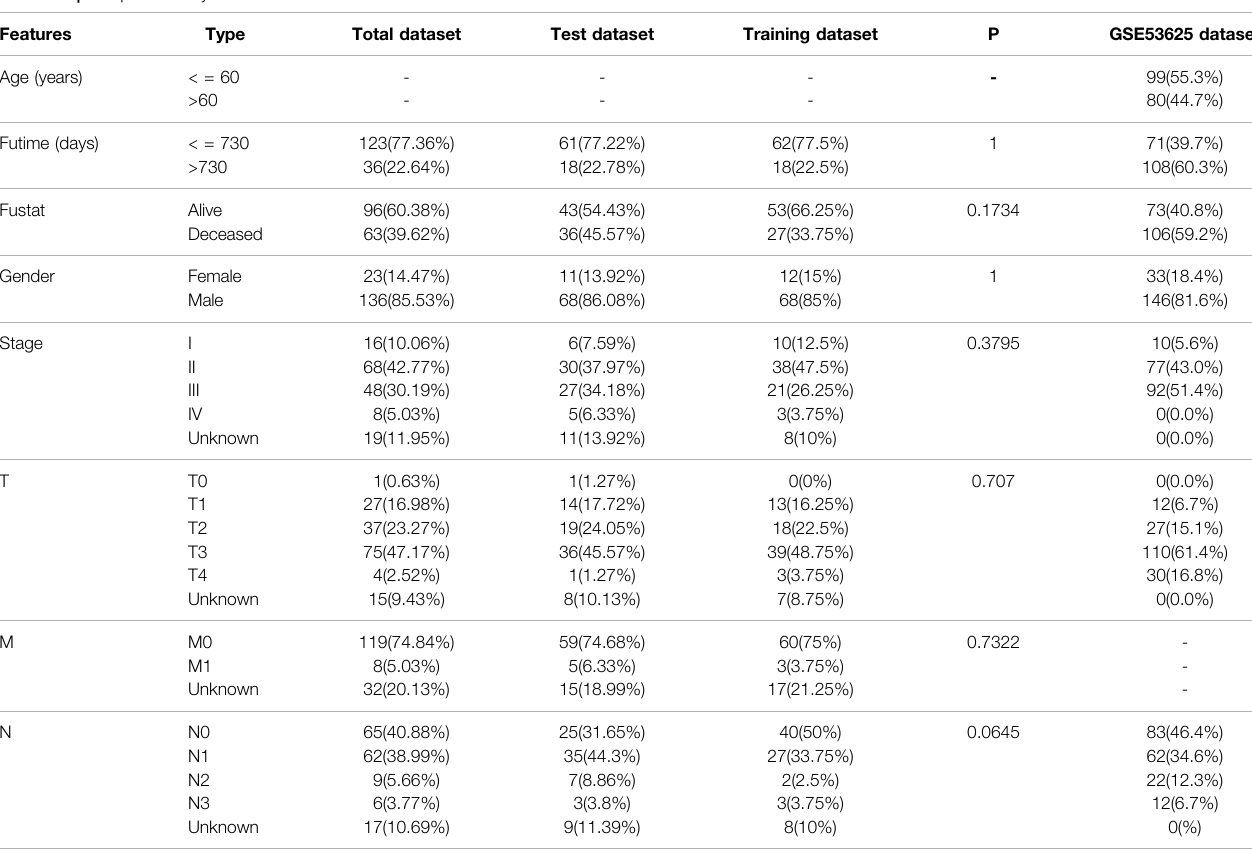
TABLE 1 | Sample sizes by clinical characteristic in the four data